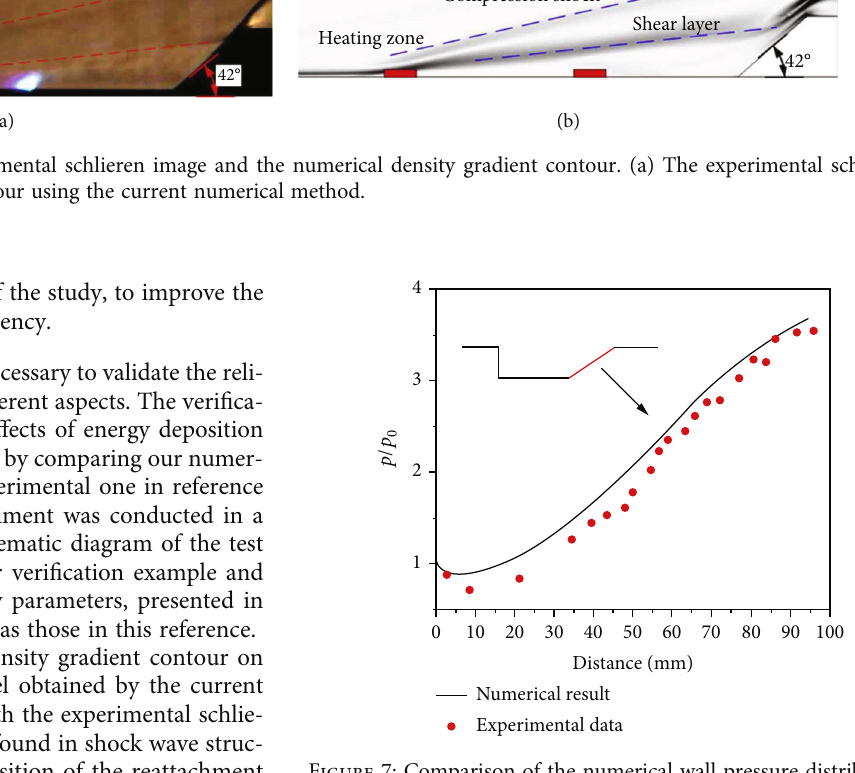
Figure 7: Comparison of the numerical wall pressure distribution with the experimental